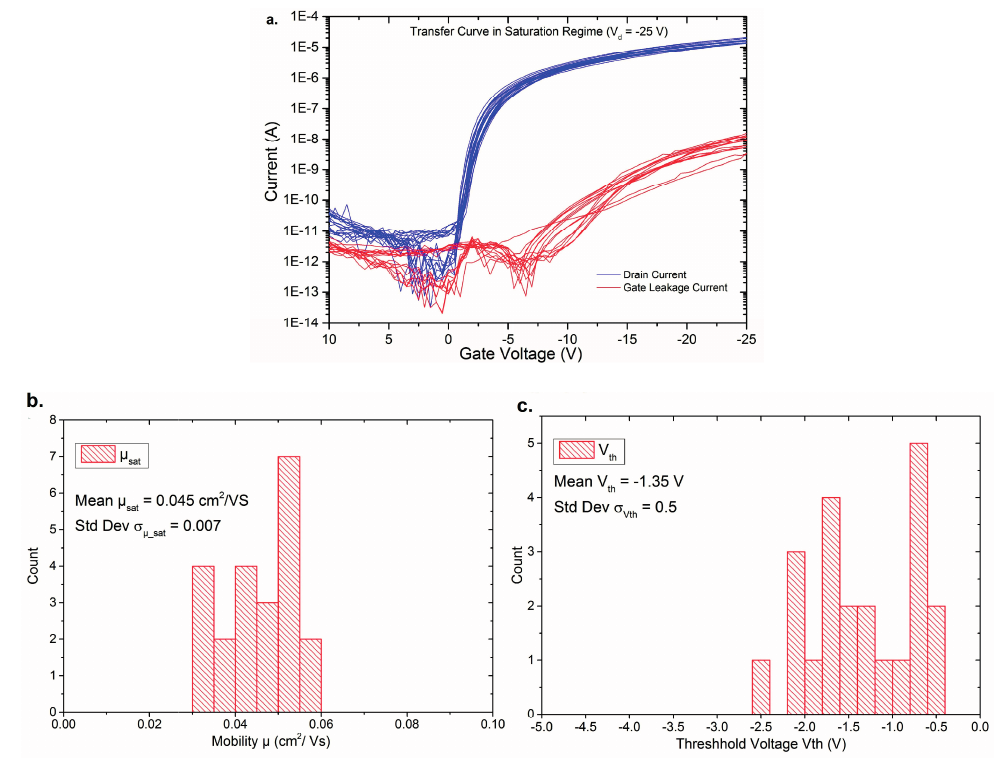
Figure 12. Plot showing the tight grouping of the ( a ) transfer curves and the histogram results of ( b ) the mobility in the saturation regime and ( c ) the threshold